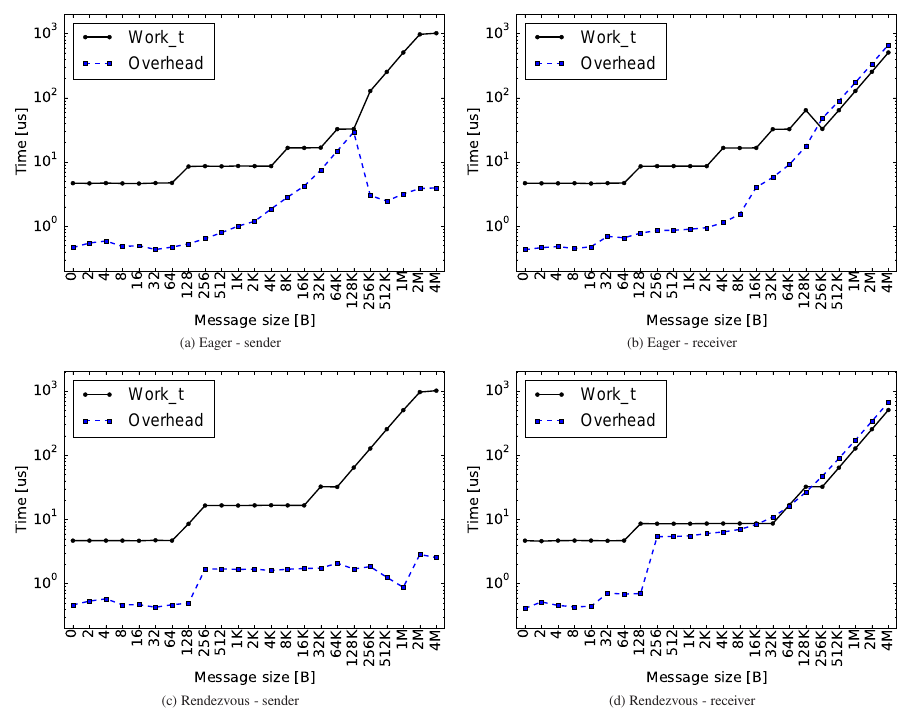
Figure 1. Results from the Sandia MPI Micro-Benchmark using the IBM MPI implementation with Eager protocol (top) for sending (a) and receiving (b) an asynchronous non-blocking message and Rendezvous protocol (bottom) for sending (c) and receiving (d) . Here, overhead corresponds to the amount of overhead time required to send or receive a non-blocking message, while work_t corresponds to the amount of computation required to effectively hide the costs of sending or receiving the message.